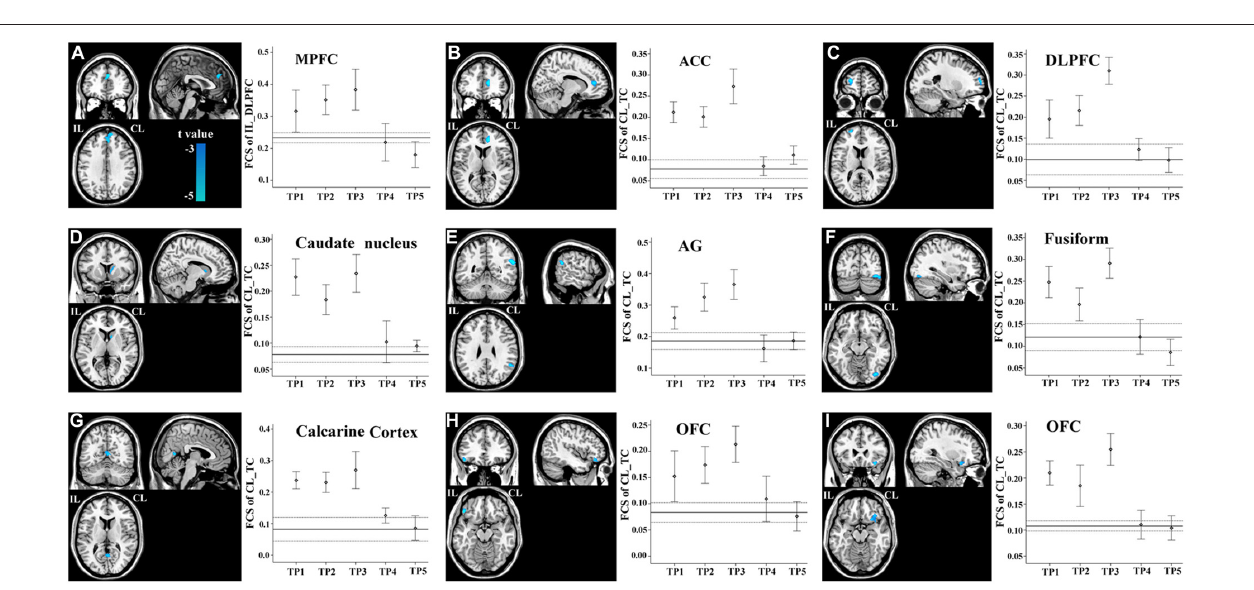
FIGURE 6 | Brain regions with linear decrease in FCS with the ipsilesional DLPFC and contralesional TC . A–I show the various brain regions with linear decrease in FCS with the ipsilesional DLPFC and contralesional TC; and the solid and dashed lines demonstrate the mean and standard error of the FCS in normal controls, respectively. Error bars illustrate the standard error. ACC, anterior cingulate cortex; AG, angular gyrus; CL, contralesional; DLPFC, dorsolateral prefrontal cortex; FCS, functional connectivity strength; IL, ipsilesional; MPFC, medial prefrontal cortex; OFC, orbitofrontal cortex; TC, temporal cortex; TP, time